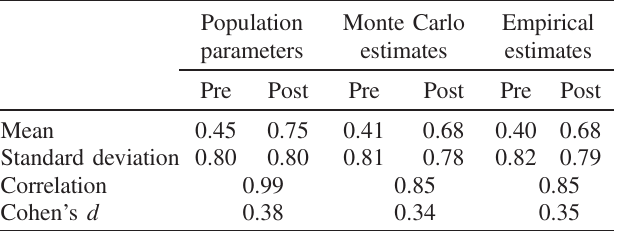
TABLE IV. We chose population parameters of true proficiency for the Monte Carlo simulation (left column) such that the parameters estimated by the simulation for the full-length FCI (center column, N ¼ 100 000 ) would be similar to the parameters measured by the empirical data β (right column, N ¼ 78 ).